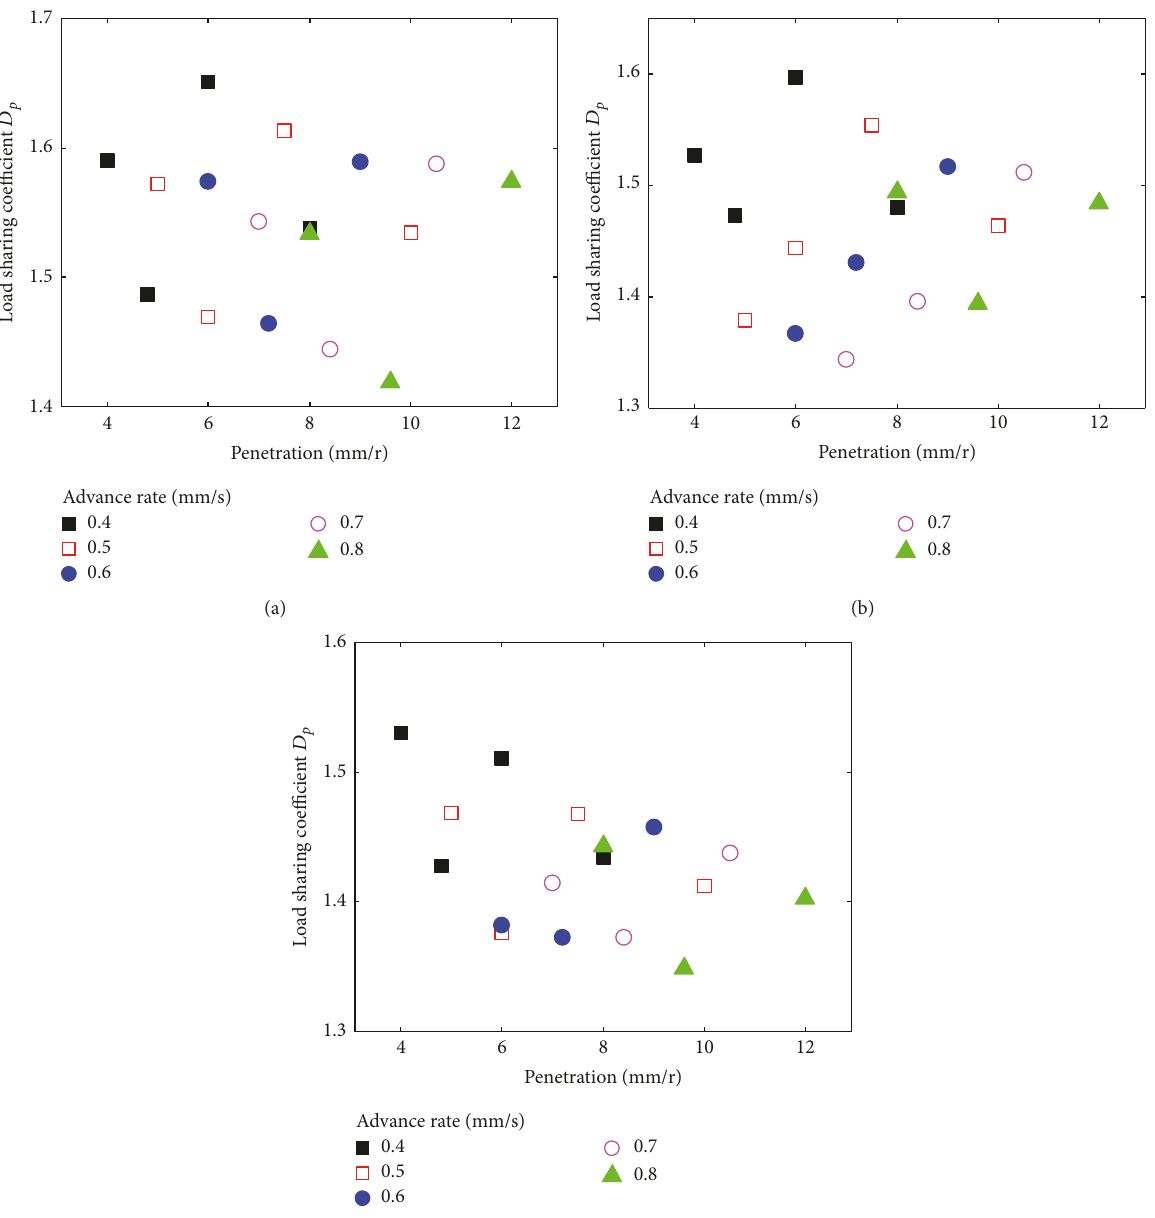
Figure 11: Correlation of load sharing coefficient and operational parameters for (a) soft rock, (b) moderately hard rock, and (c) hard rock.